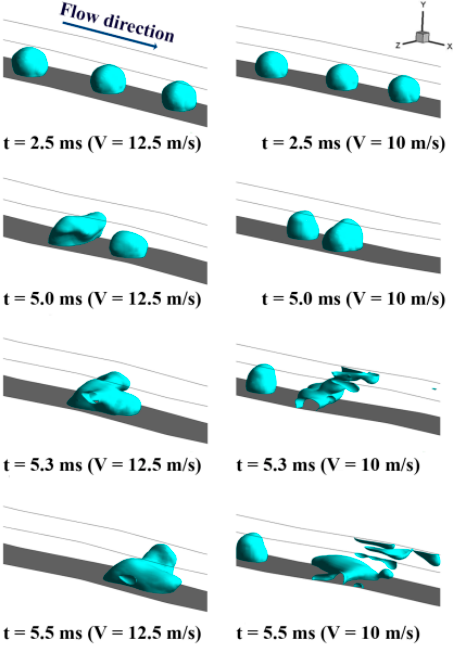
Figure 10. Droplet interaction at different time instances and inlet velocity under the same contact angle ( θ GDL = 120°, θ side; top = 82°; 82° respectively) for Design 1.